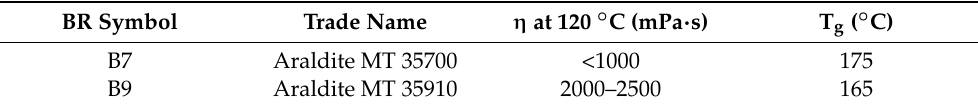
Table 1. Characteristic of tested benzoxazine resins